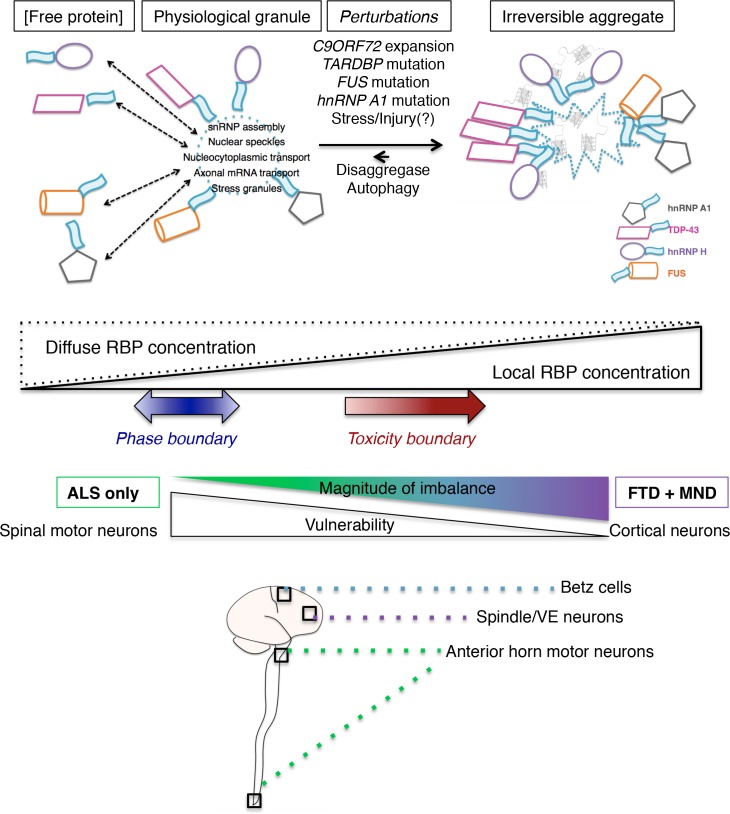
A model for a multi-RBP proteinopathy and splicing dysregulation as a common mechanism underling ALS/FTD pathogenesis.A model of a multi-RBP proteinopathy, where several disease-related proteins (hnRNP H, TDP-43, FUS, hnRNP A1) can exist in different states: free/soluble, phase separated into reversible granules, and trapped in overly mature granules or aggregated RNA/protein assemblies. The relative balance of these states can be influenced by known ALS/FTD mutations, or normal fluctuations due to experience, thus altering the cellular distribution of RBPs between diffuse and localized/sequestered states. We envision a theoretical ‘toxicity boundary’ beyond which RBPs are disproportionately in the highly concentrated state, and functional levels of soluble protein are low. We propose that the distance past this boundary, or magnitude of the imbalance between free and local RBP concentrations, is correlated to a greater involvement of cortical neuron dysfunction, whereas mild imbalance is sufficient only to cause MN death. Thus our model implies a gradient in vulnerability, with spinal MNs being more sensitive to this imbalance than cortical MNs, which are more vulnerable than neurons (such as spindle/VE (Von economo)) that are predominantly affected in FTD.